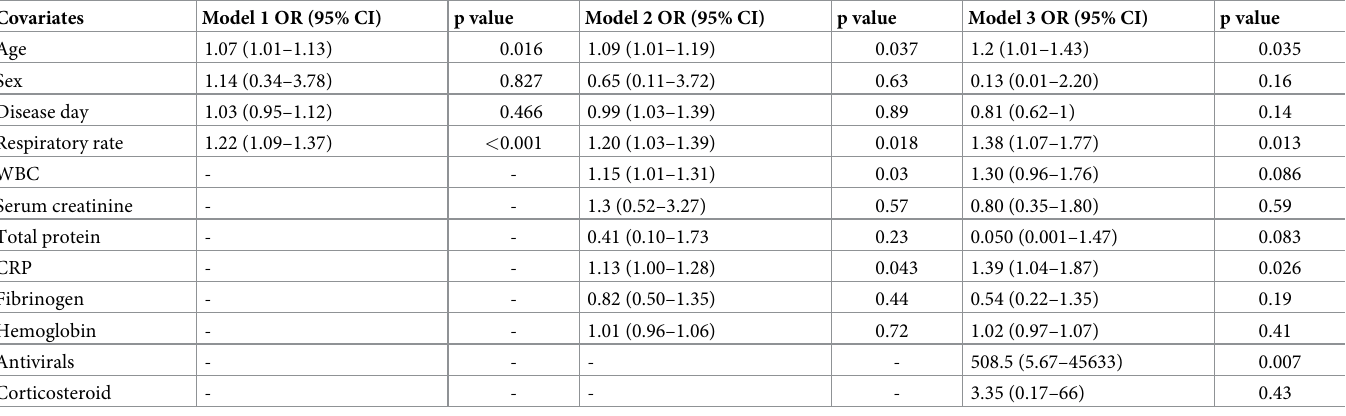
Table 3. The association between demographics, clinical, laboratory, treatment related variable and risk of in-hospital death using adjusted logistic regression models. Covariates